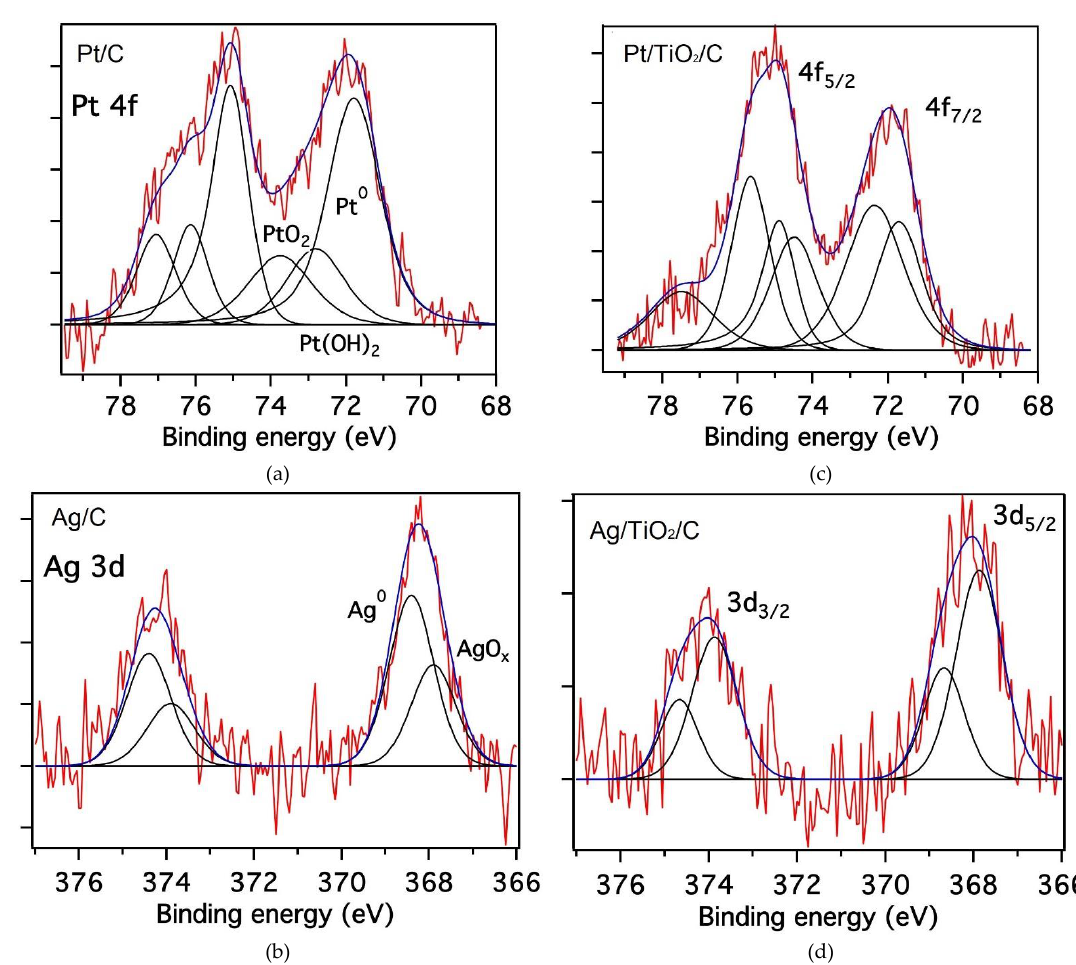
Figure 2. Deconvoluted Pt 4f and Ag 3d XPS spectra for ( a ) 1% Pt/C, ( b ) 1% Ag/C, ( c ) 1% Pt/TiO 2 /C, and ( d ) 1% Ag/TiO 2 /C catalysts. Table 1. Surface composition of catalysts obtained by XPS.